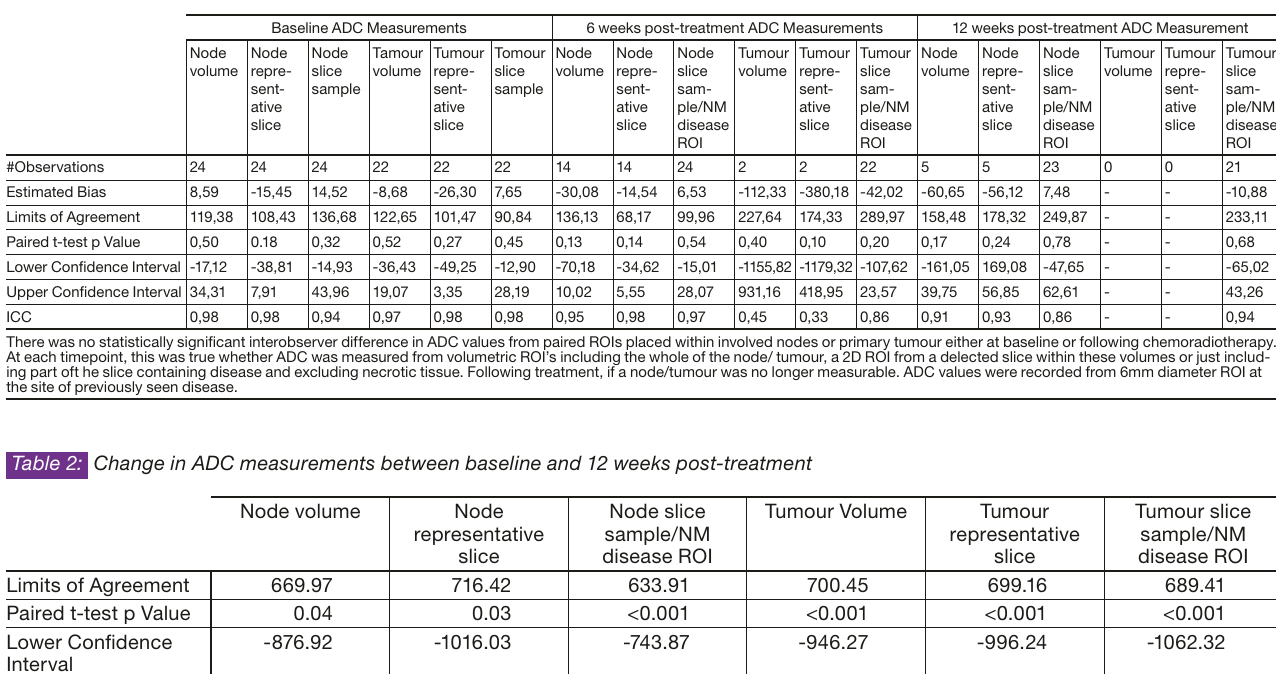
Table 1: Interobserver comparison of ADC measurements at baseline and post-treatment